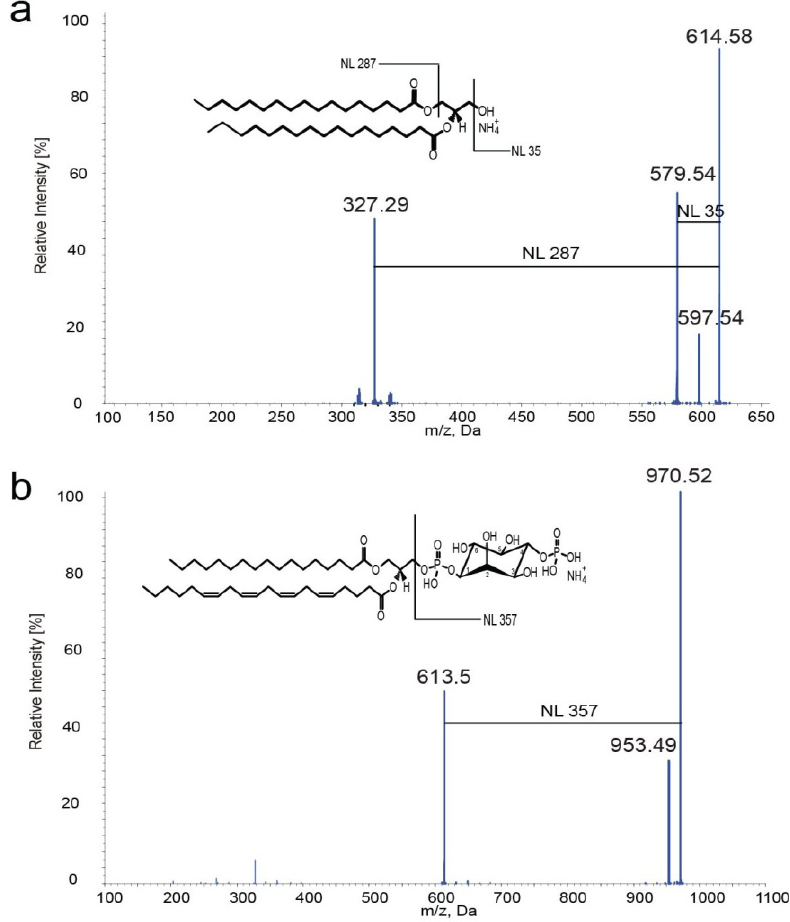
Figure 2. Fragmentation of DAG, PIP and PIP of DAG 17:0/17:0 ( a ), PI(4)P 17:0/20:4 ( b ) and PI(4,5)P fragment ions and corresponding neutral losses are